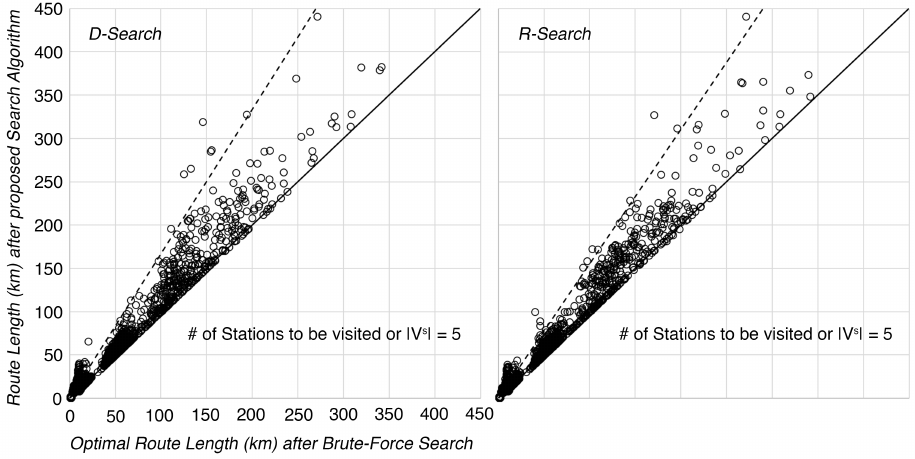
Figure 7. Graph comparing the absolute route lengths for brute-force and D-Search/R-Search approaches. It can be seen that the intensity of the error increases with increase in the length of the trip. Although only | V s | = 5 instance is plotted here, a similar fanning-out behavior (dashed- and solid-line) is observed for other cases too. Severe errors are expected for long trips irrespective of the choice of algorithm or complexity of